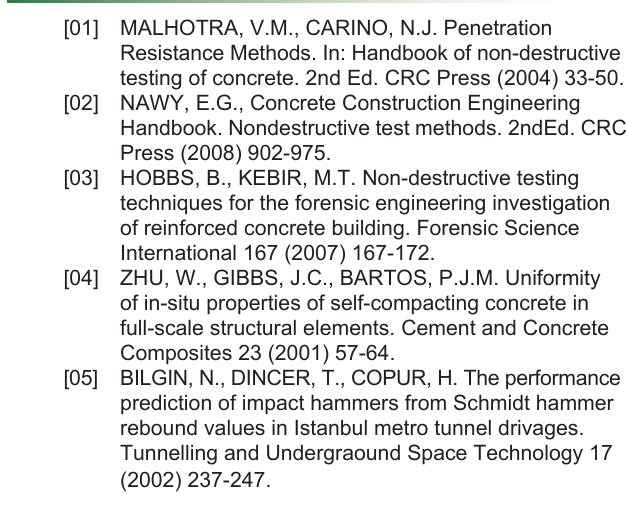
Table 5 – Characteristic compressive strength of the shotcrete lining in different stretches of the tunnel